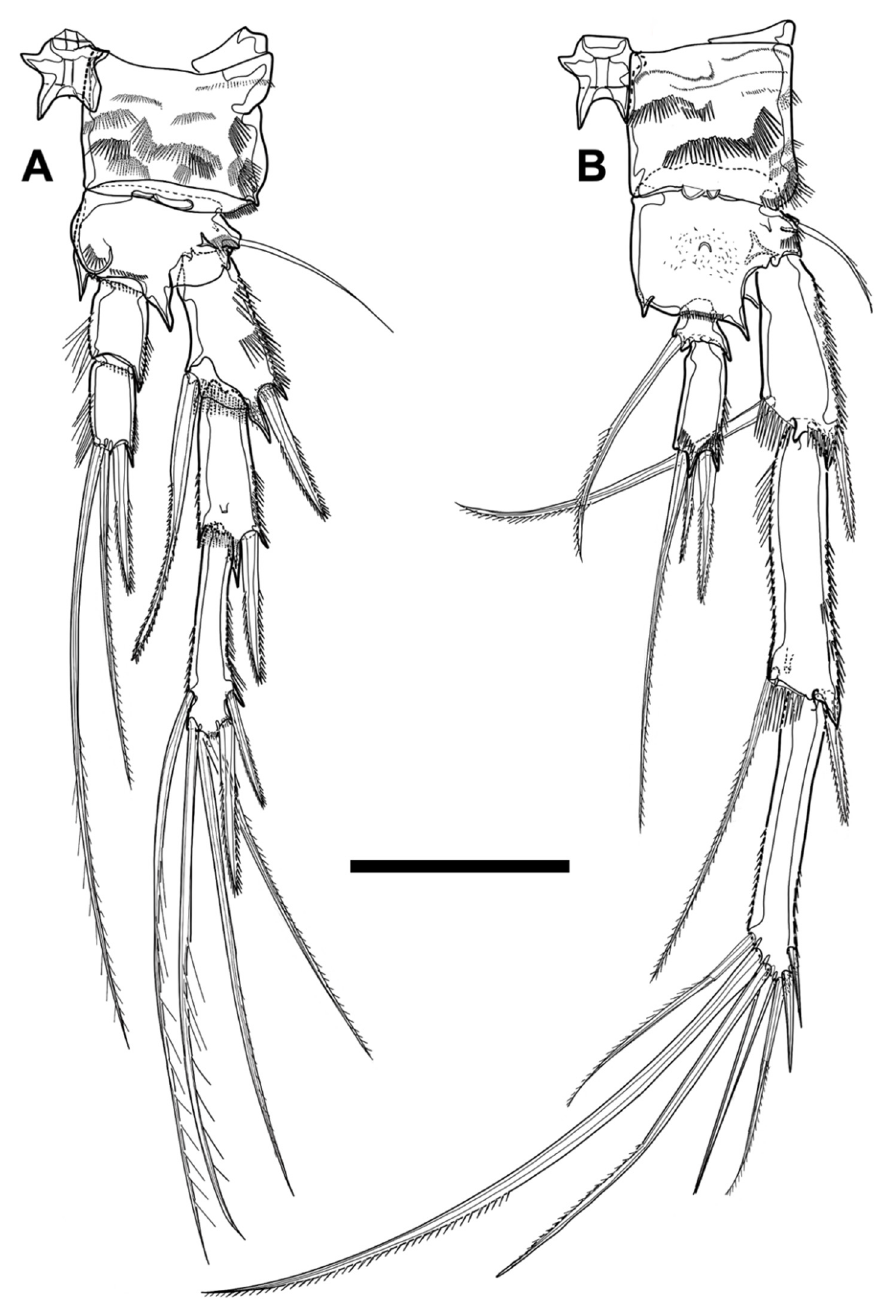
Figure 30. Line drawings of Phyllopodopsyllus similis sp. nov. female (holotype): ( A ) P3; ( B ) P4. Scale bars: 50 µm.